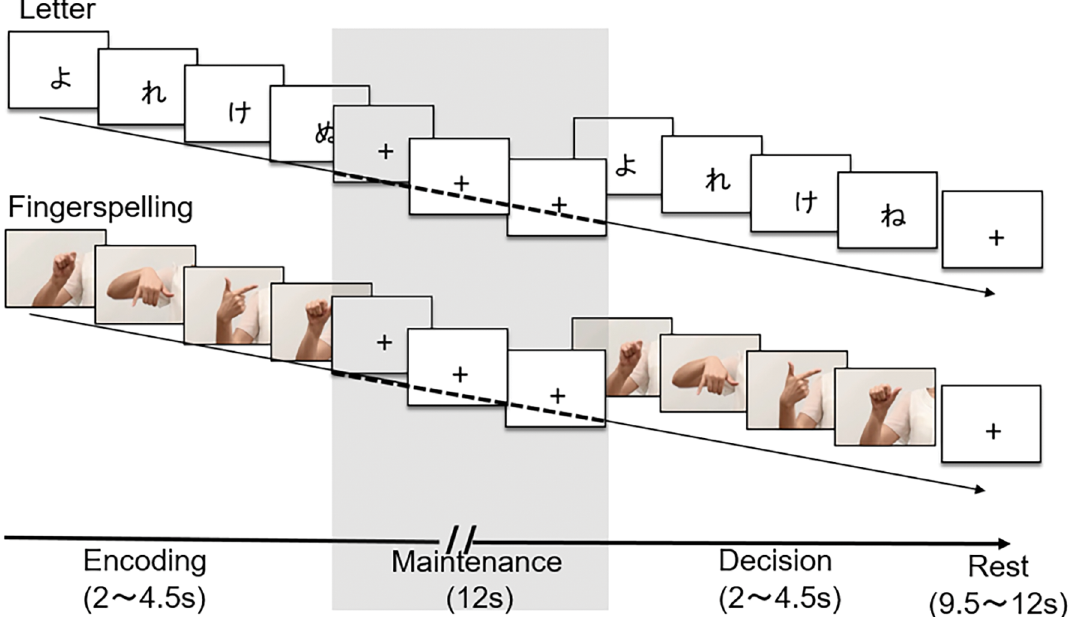
Fig 1. Experimental design of the sequence memory span task. On each trial, a nonsensesequenceof 4–7 syllables was presentedeither as letters (Japanese kana) or as fingerspelling. Participantswere instructed to read and memorize the first syllablesequenceduringencodingstage and keep the syllable sequencefor 12 secondsduring maintenance stage (highlighted). They then viewedanother syllablesequenceand decidedby key-press whether or not two sequenceswere identicalduringthe